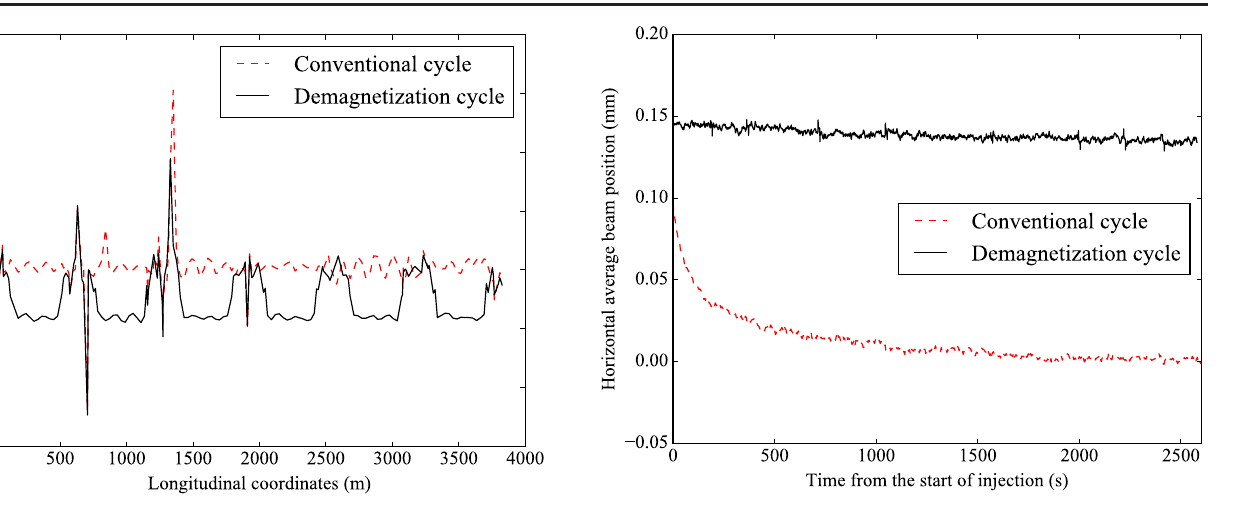
FIG. 7. The horizontal orbits shifted inwards by 1.8 mm in the dispersive regions due to the change of RHIC dipole magnet field with the demagnetization cycle.